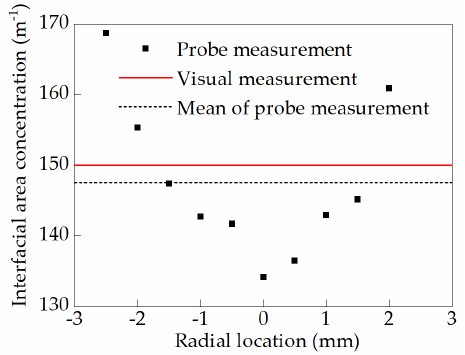
Figure 11. IAC from probe and visual measurement.